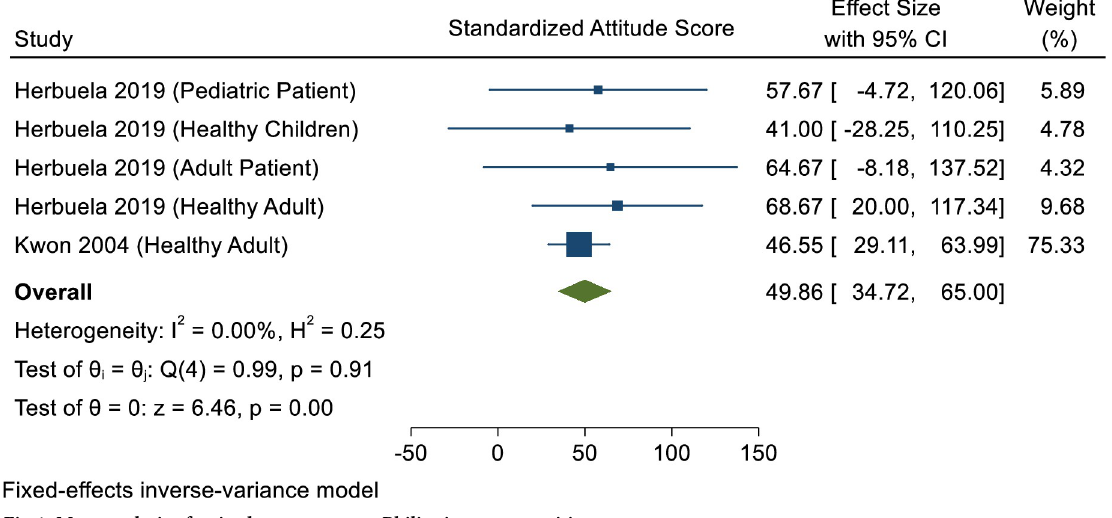
Fig 4. Meta-analysis of attitude scores among Philippines